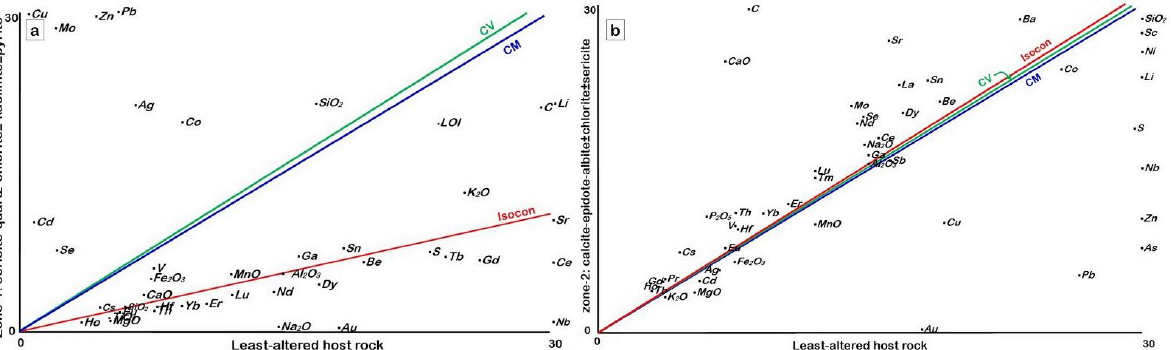
Figure 12. Metal content classification diagram after Large [50]. The ratios ZR= (100 Zn/(Zn + Pb) and CR= 100 Cu/(Cu + Zn) are based on the average ore grades in mass percent after Large [50].